Question: Give a one-sentence summary of this figure.
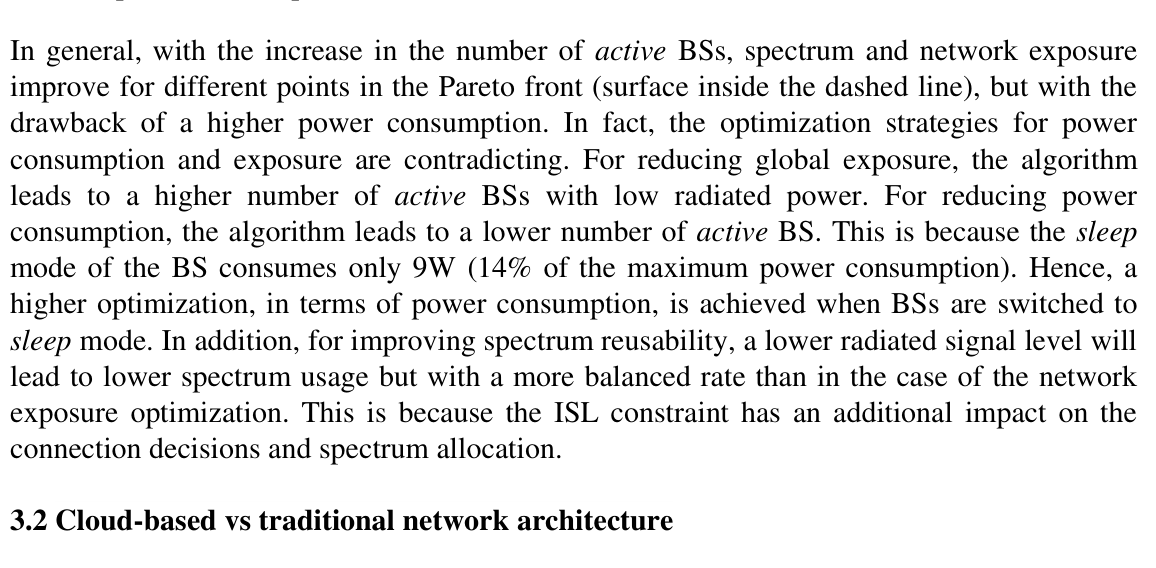
Answer: shows the difference (in percentages) for each pareto point in the cloud-based  architecture and the traditional distributed architecture for 22 BS.